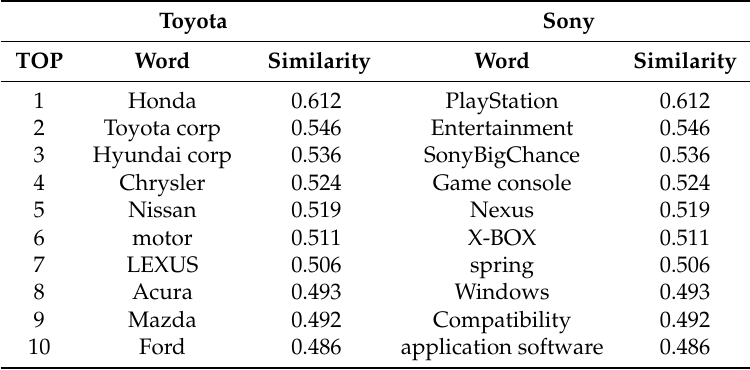
Table 1. Example of similarity relationship for Japanese words (translated).